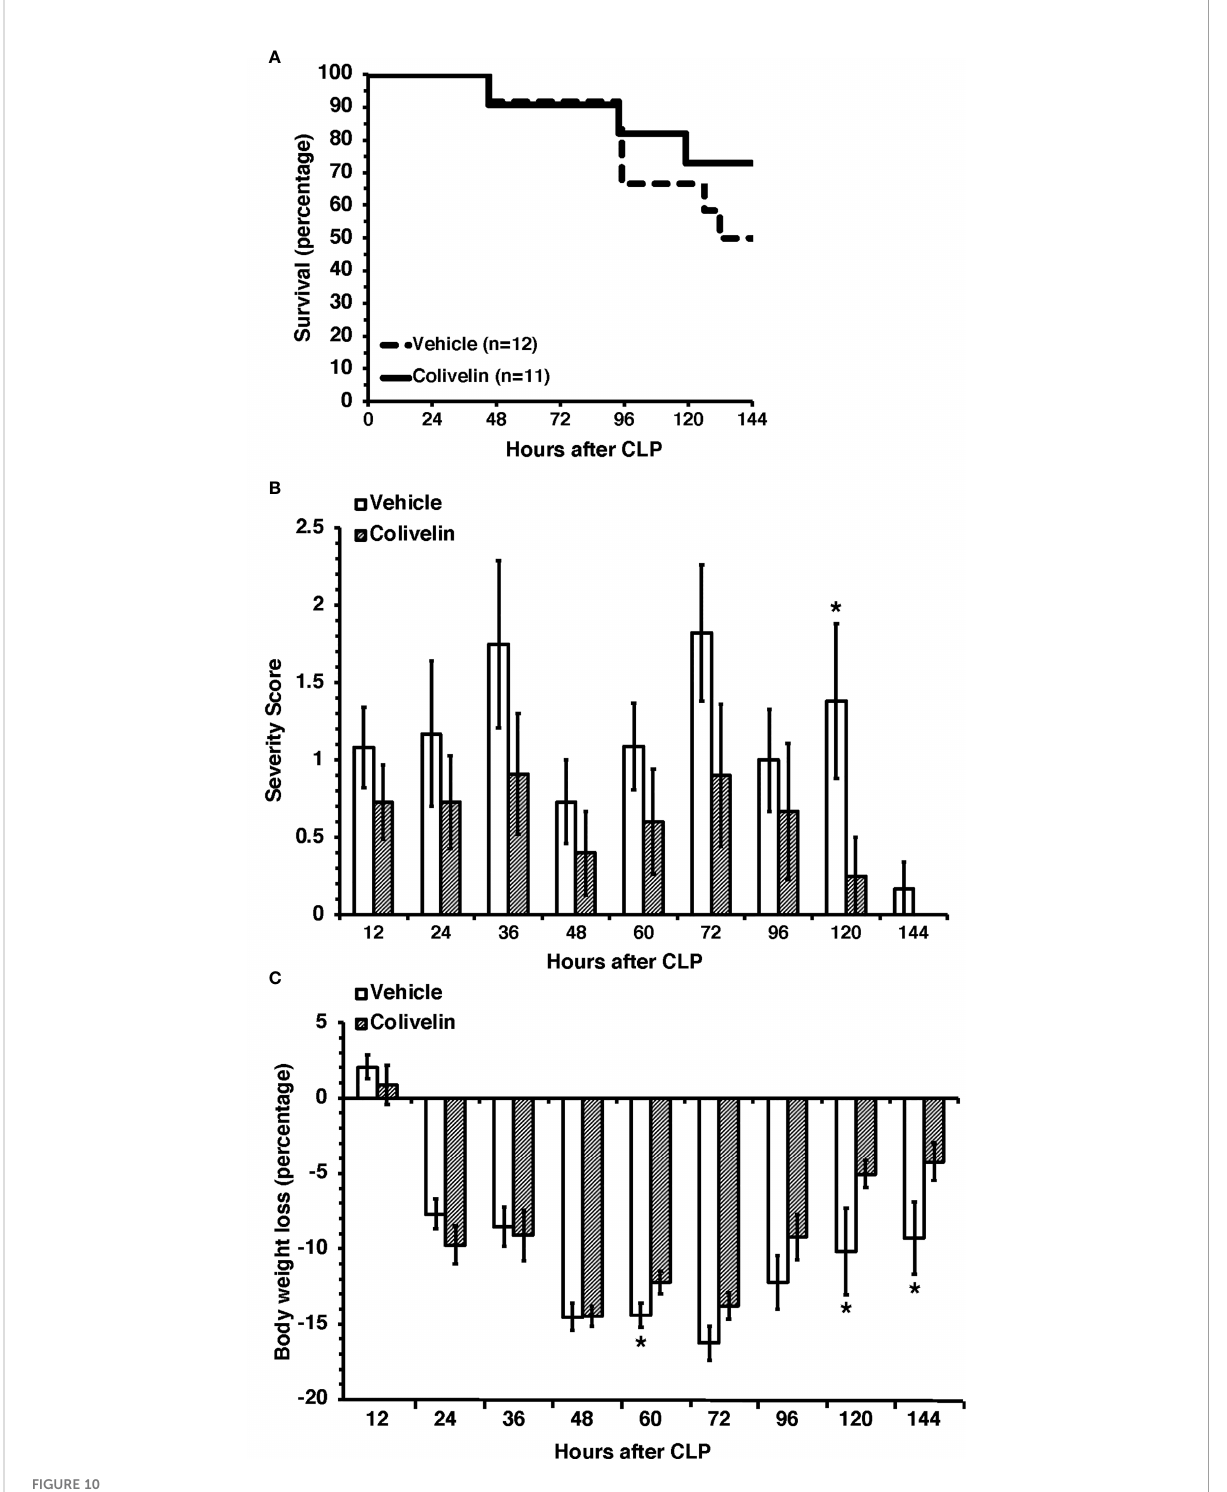
FIGURE 10 Survival rate (A) , severity score (B) and body weight loss (C) of mice at 7 days after cecal ligation and puncture (CLP). Mice were subjected to CLP and received colivelin (100 µg/kg subcutaneously) or vehicle at 1 h, 3 h and 24 h after CLP. All mice received fl uid resuscitation (35 ml/kg normal saline with 5% dextrose subcutaneously) every 24 h up to 7 days and ceftriaxone (25 mg/kg) and metronidazole (12.5 mg/kg) intraperitoneally every 12 h up to 3 days after the CLP procedure. *Represents P < 0.05 versus colivelin-treated